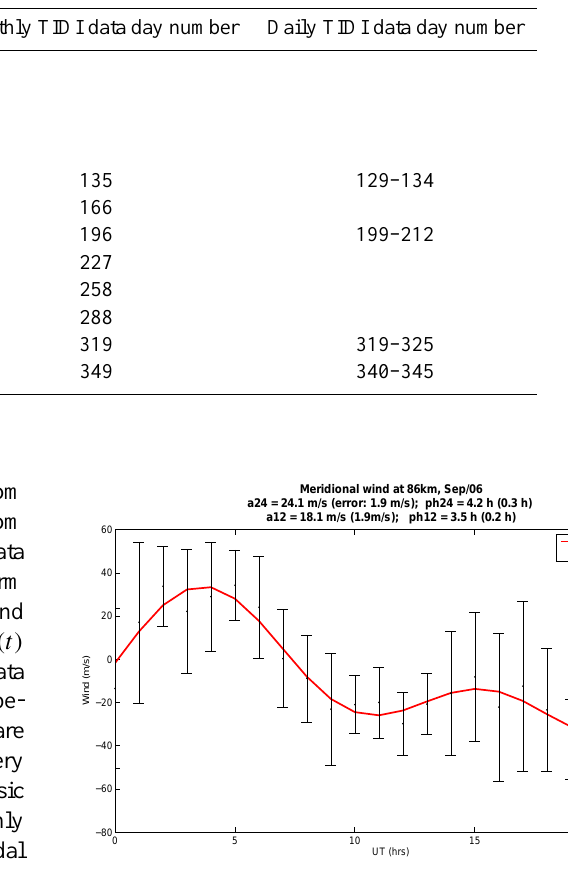
satellite precesses slowly and can cover 24 h in local time for every 60 days (Wu et al., 2008). With the assumption that there is no fast temporal variation, we perform the same har- monic fit (Eq. 1) to the 60-day averaged monthly TIDI data at 15 ◦ S from 2006 to 2007 (courtesy of Qian Wu of High Altitude Observatory) to extract tidal information so that the comparison with JASMET data can be made (see Table 2 for the monthly TIDI data used in comparison). Reconstructed